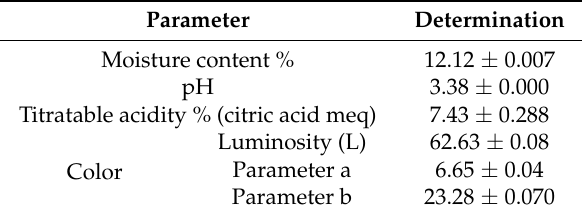
Table 1. Physicochemical characterization of the Persian lime Citrus x latifolia flour waste.